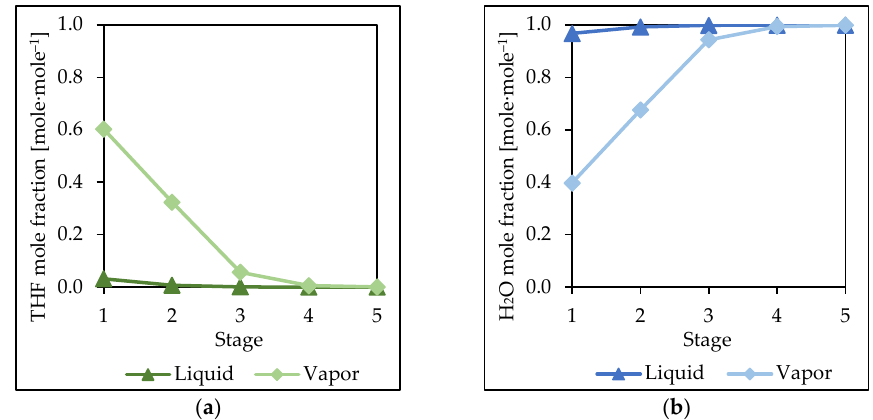
Figure 5. ( a ) THF mole fraction of the liquid and vapor phase inside the stripping column and ( b ) H 2 O mole fraction of the liquid and vapor phase inside the stripping column. As it can be inferred from the mole fractions, a large part of the purification can already be achieved with four stages.